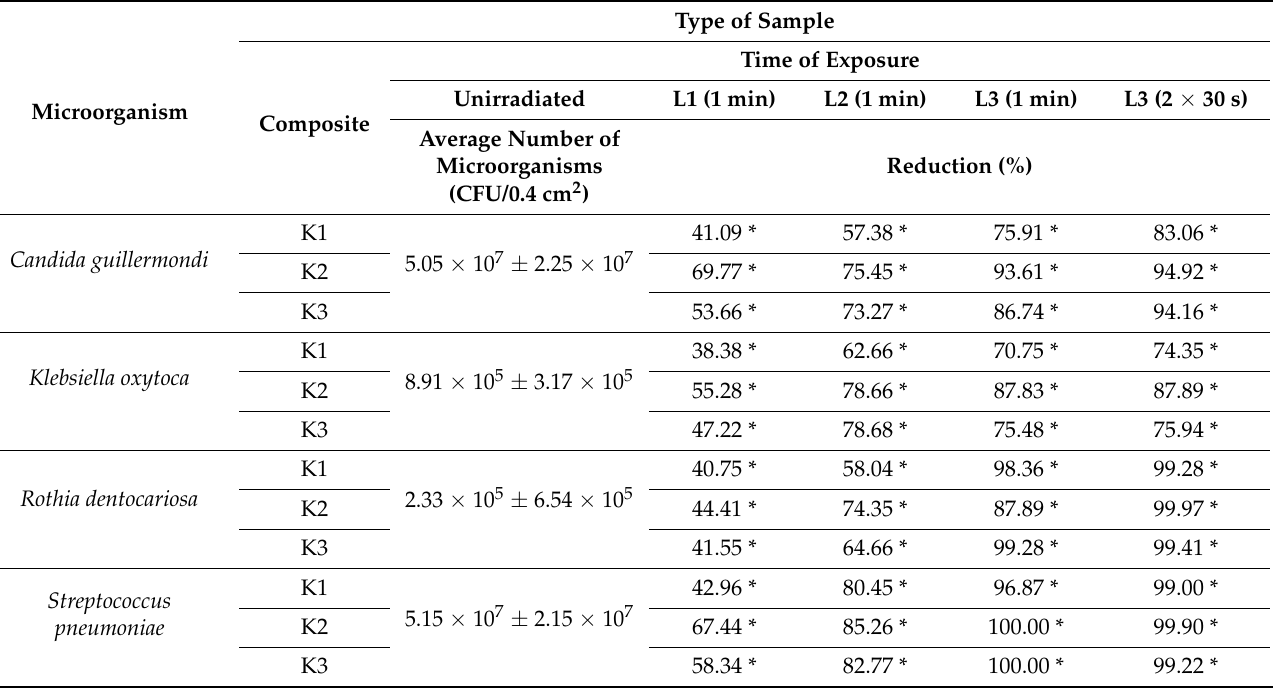
Table 4. The results of the effectiveness of laser irradiation against the most common and pathogen microorganisms on the